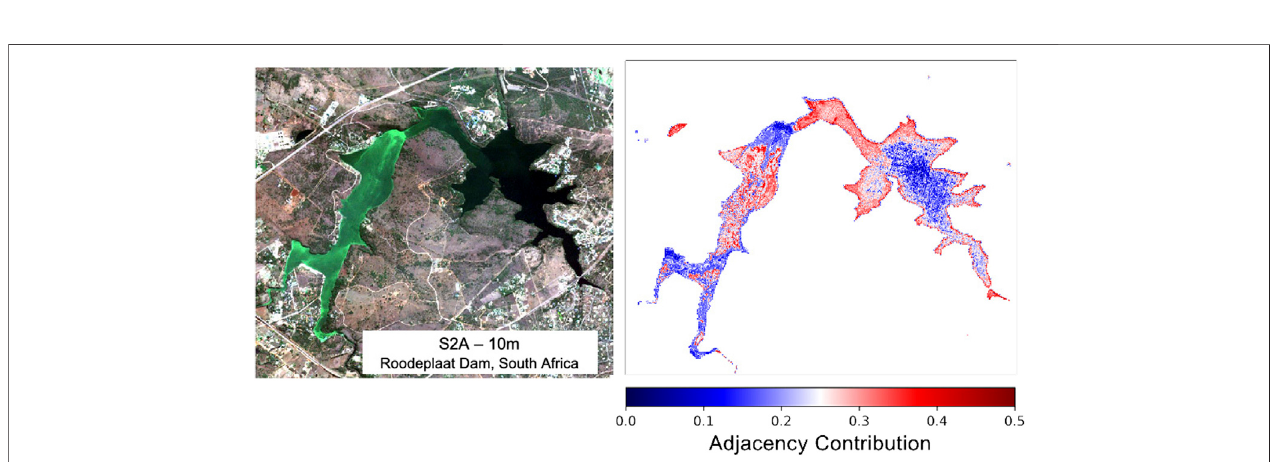
FIGURE 14 | Percent adjacency contribution derived using RF regression over Roodeplaat Dam, South Africa, using TOA re fl ectance data.